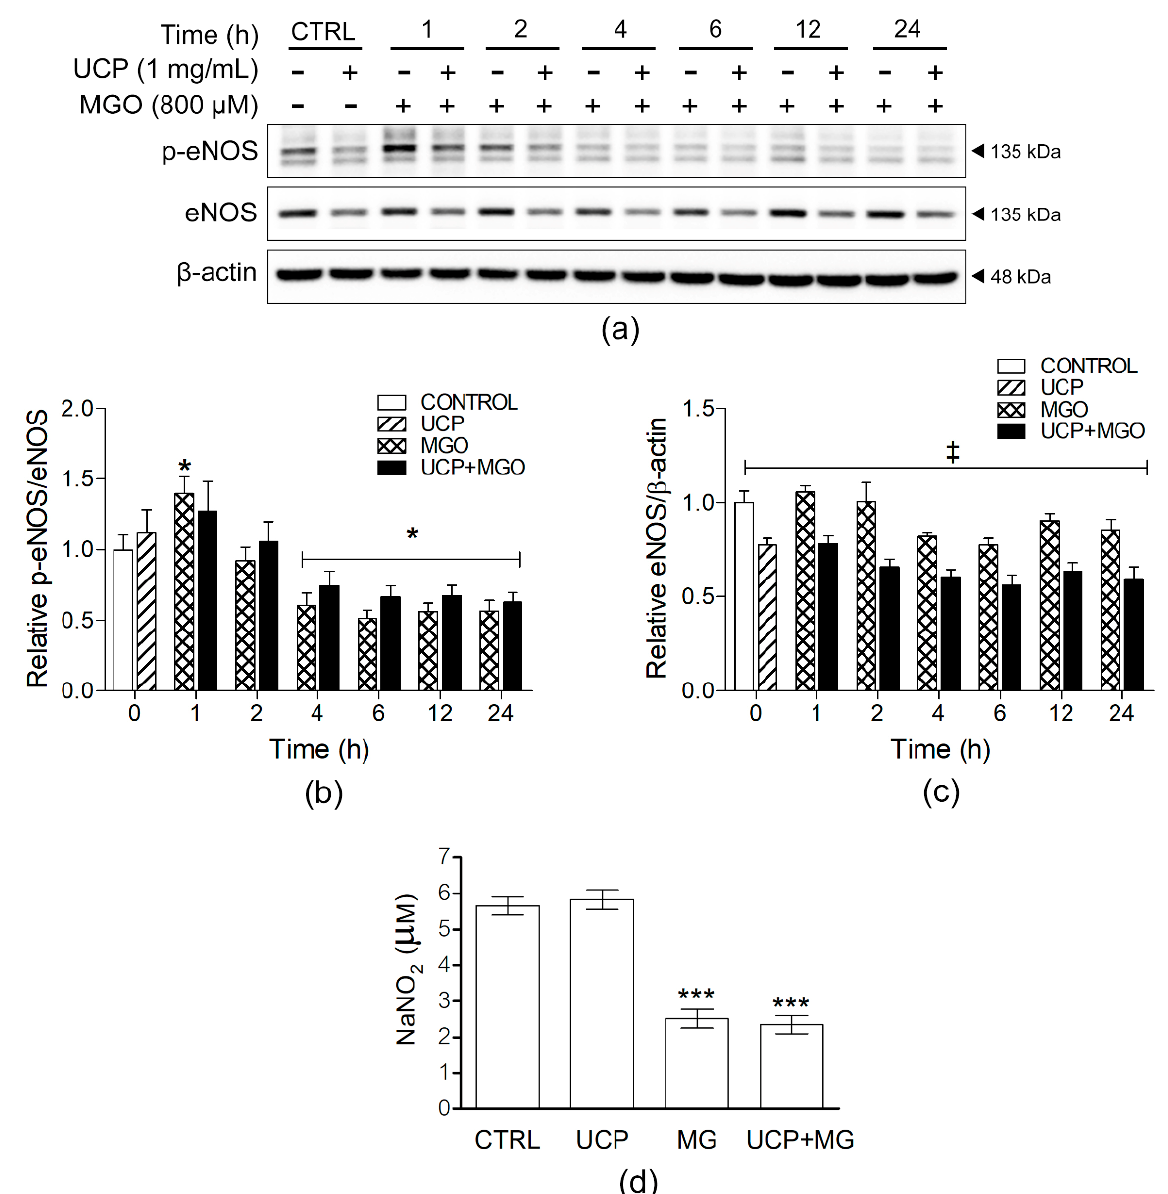
Figure 5. Effects of UCP pretreatment on eNOS phosphorylation and nitric oxide levels in EA hy926 cell exposed MGO. ( a ) Representative Western blot protein bands of cell lysates from each sample group. ( b ) Relative ratios of p-eNOS/eNOS and ( c ) p-eNOS/ β -actin. ( d ) NO releasing levels from cells in each treatment group. Data are presented as mean ± SEM. *, p < 0.05; ***, p < 0.001, when compared with vehicle-treated group; ‡, p < 0.05, when compared MGO-exposed group at the same time point. Figure 7 and Figure S3 present Western blot analyses of signaling phosphorylation of Akt, JNK, and p38. Endothelial cells exposed to MGO showed significant increases in Akt phosphorylation within 1 h (2.06 ± 0.13 folds) and decreased afterward to the basal level within 24 h (Figure 7b). UCP pre-treatment significantly inhibited the early activations of Akt phosphorylation at 1 and 2 h where the ratios of p-Akt/Akt were down to 1.40 ± 0.12 and 1.12 ± 0.06 folds, respectively. Correspondingly, the phosphorylation of JNK and p38 also significantly increased at the same time point (2.53 ± 0.18, and 4.27 ± 0.29 folds, respectively) and diminished right after the first hour of activation (Figure 7c,d).